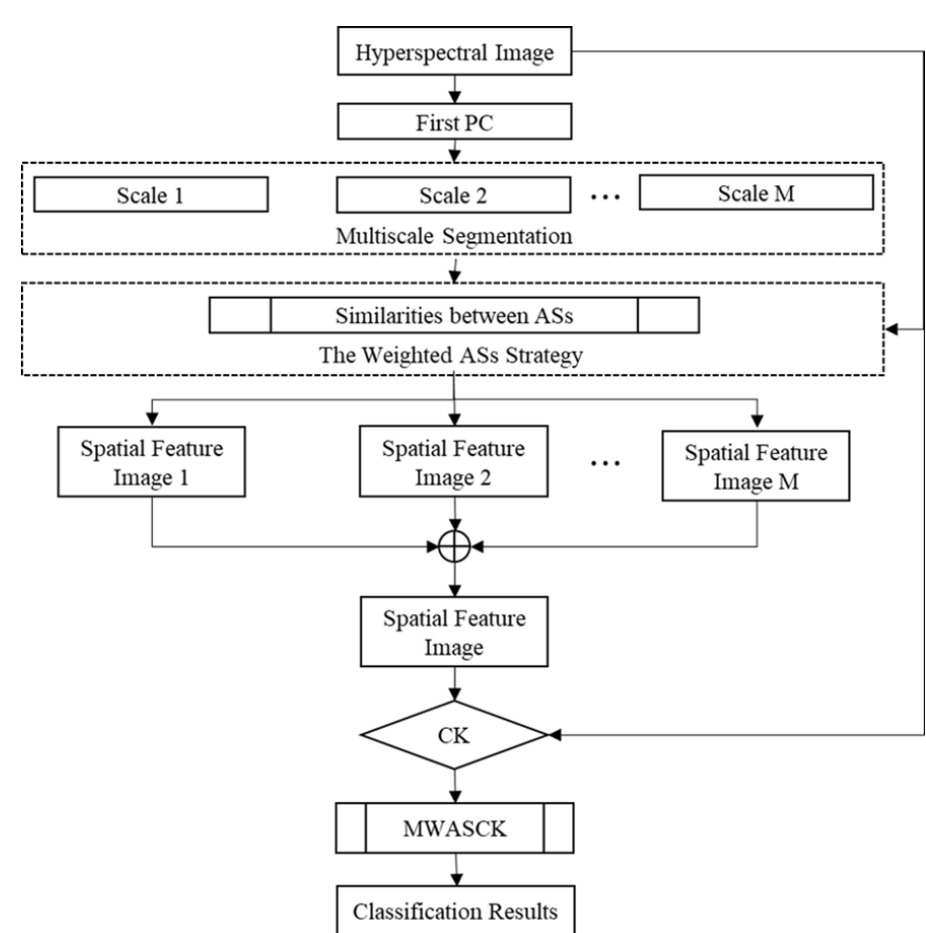
Figure 2. Flowchart of the proposed composite kernel based on multiscale weighted adjacent superpixel (MWASCK) method.